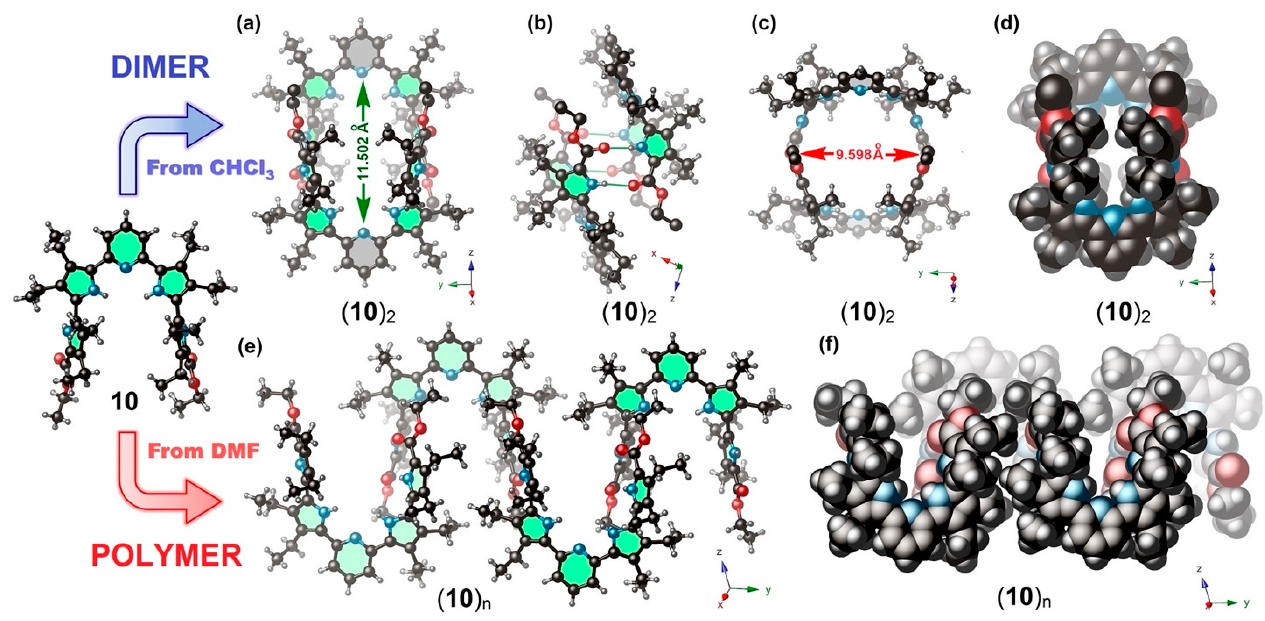
Figure 2. ( a ) Single crystal X-ray structures of receptor 10 grown from two different solvents under ambient conditions. Panels ( a – d ) represent a discrete supramolecular dimeric pseudo-macrocyclic cage-like structure of the receptor with the empirical chemical formula ( 10 ) 2 grown from anhydrous CHCl 3 . ( e , f ) The single-crystal X-ray structure of receptor 10 represents a “zig-zag” 1D hydrogen-bonded supramolecular polymer with empirical chemical formula ( 10 ) n grown from anhydrous N , N -dimethylformamide (DMF). For clarity, the solvent molecules (CHCl 3 and DMF) are omitted from the ( 10 ) 2 and ( 10 ) n crystals, respectively.